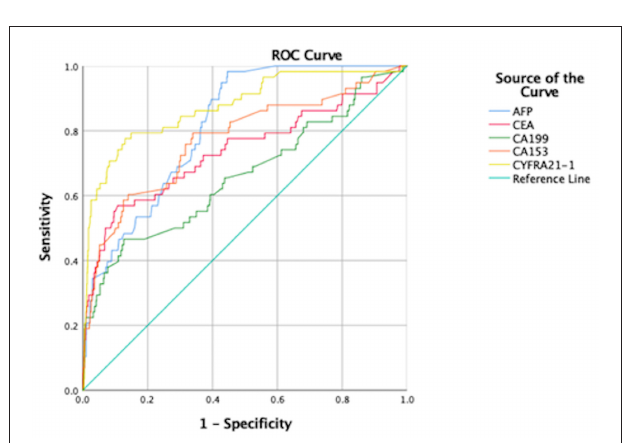
FIGURE 5 | Comparison of ROC curves for tumor markers as independent risk factors. AUC, area under the ROC curve; ROC, receiver operating characteristic curve; AFP, alpha fetoprotein; CEA, carcinoembryonic antigen; CA, cancer antigen; CYFRA, cytokeratin fraction.